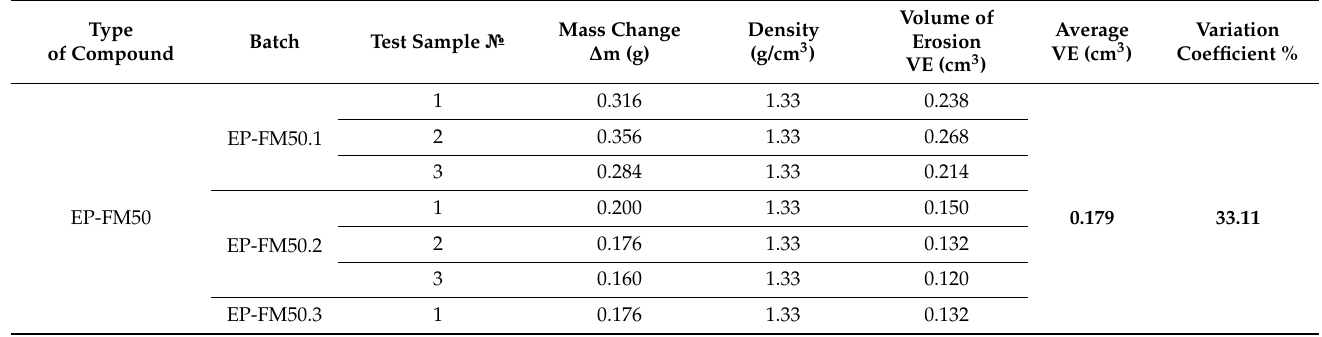
Table A23. Wear of filled epoxy binder (EP-FM50) at 180 ◦ C at an impingement angle of 90 ◦ .